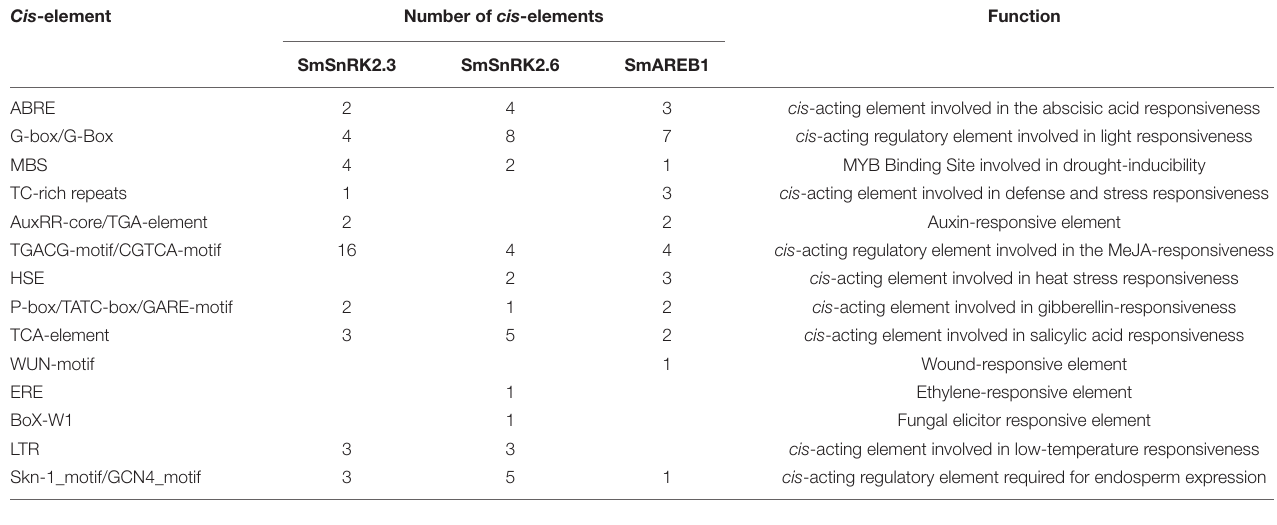
TABLE 1 | Potential cis -acting regulatory elements in the SmSnRK2.3, SmSnRK2.6, and SmAREB1 promoter with the exception of core cis -acting elements (TATA box and CAAT box). Cis -element Number of cis -elements